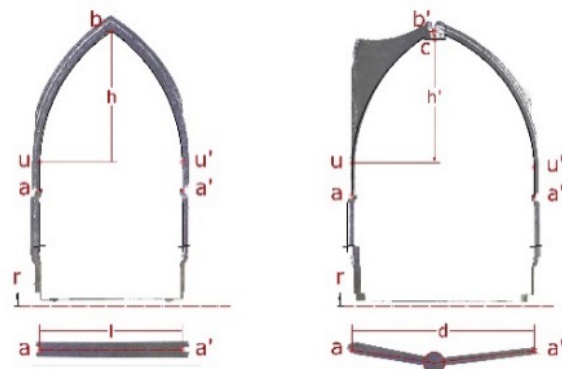
Figure 2: Two-dimensional parameters to be obtained from the arches (left) and ribs (right).